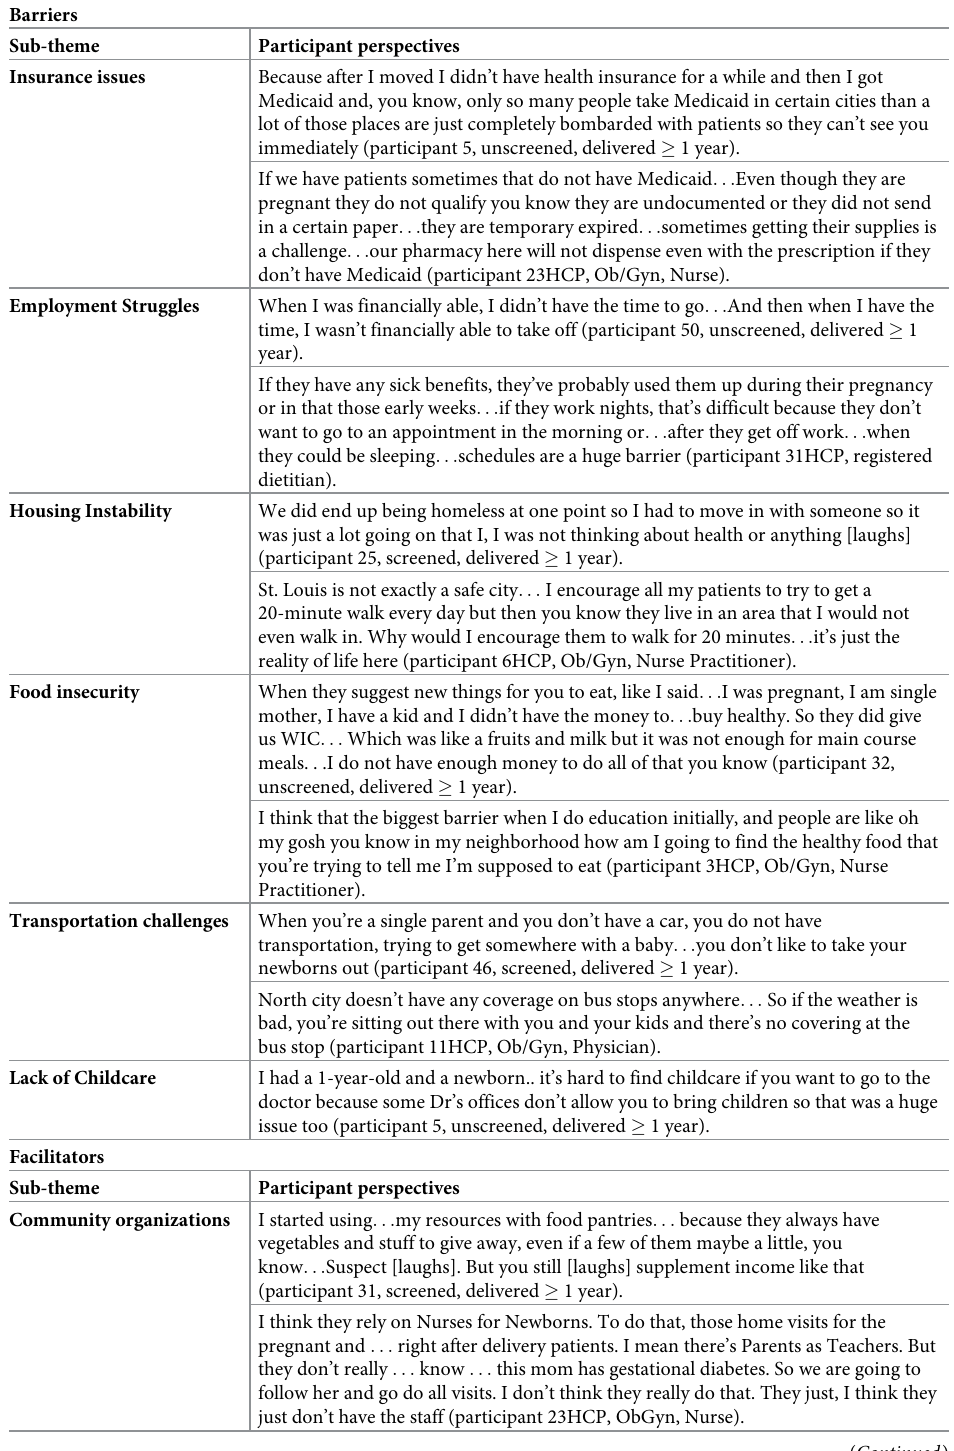
Table 2. Societal level barriers and facilitators to postpartum diabetes screening and prevention: Exemplar